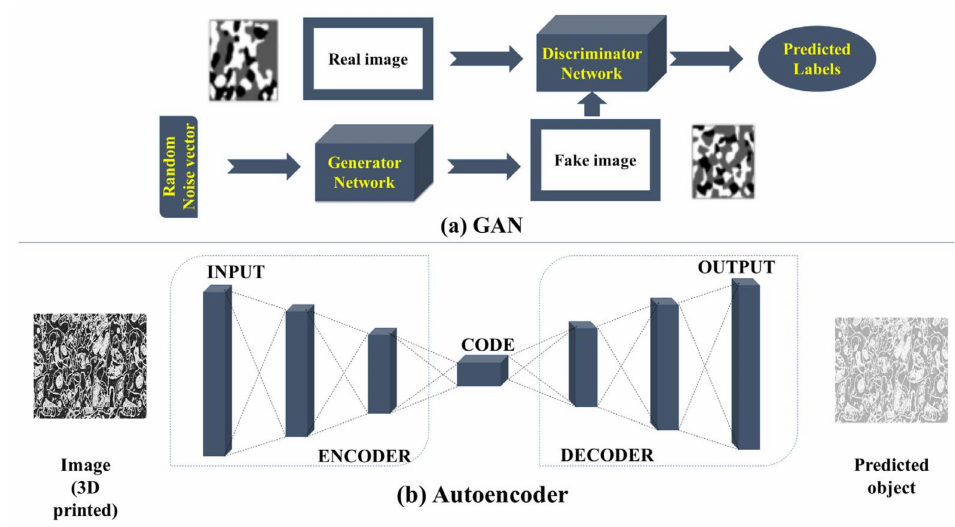
Figure 11. ( a ) Generative adversarial networks (GANs) and ( b ) Autoencoder. An autoencoder is used for unsupervised learning data encodings. An autoencoder trains the network to identify the key elements of the input image to learn a lower- dimensional representation (encoding) for higher-dimensional data, generally for dimen- sionality reduction. Ironically, the bottleneck is the most crucial component of the neural network. The autoencoder is widely applied in noise reductions in the image. The auto- encode takes X as input and tries to generate X as output [96]. Table 6 summarizes the various literature on GAN and autoencoders. Table 6. Summary of various literature on GAN and